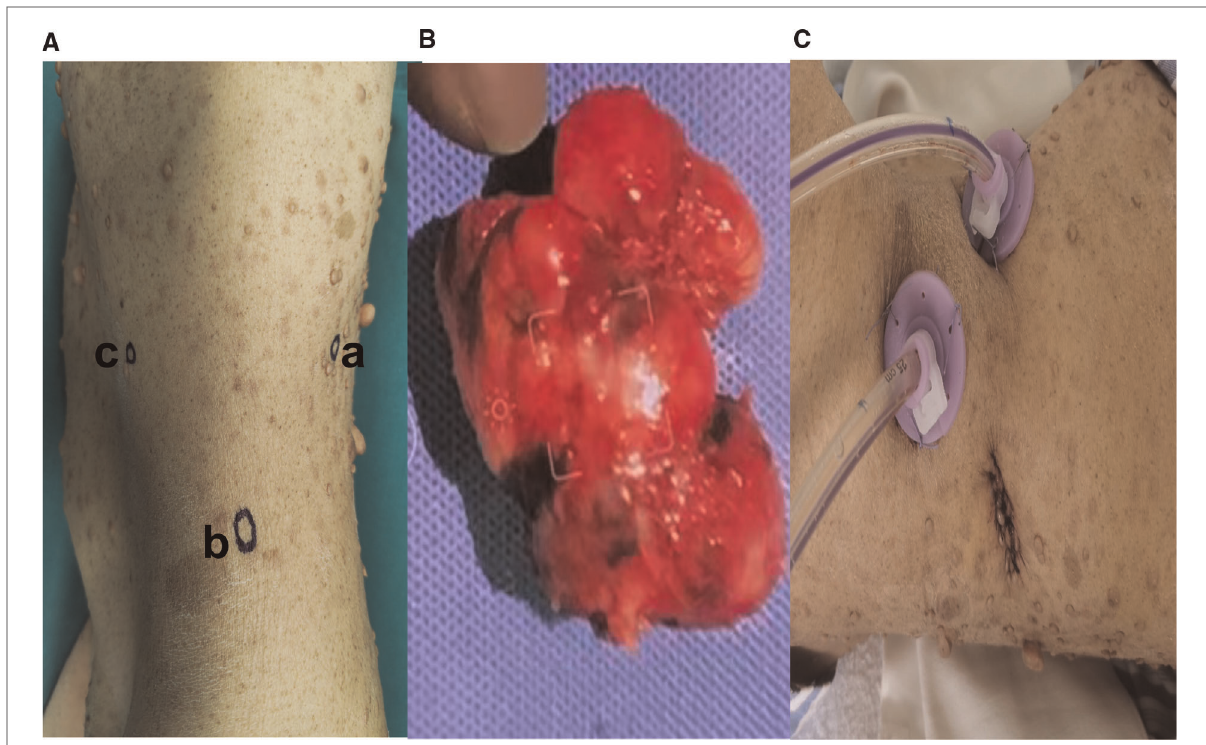
FIGURE 3 ( A ) Trocars con fi guration for left retroperitoneal laparoscopic approach; [trocar a] is inserted via 2 cm skin incision made below the 12th rib, anterior to the Sacro-spinal muscle, on the posterior axillary line and the skin incision is sutured to fi x the trocar, [trocar b] A 10 mm camera trocar is inserted two fi ngers breadths above the iliac crest on midaxillary line; [trocar c] is inserted at the subcostal margin on anterior axillary line ( B ). Extracted tumor mass specimen ( C ). Postoperative drain in retroperitoneal